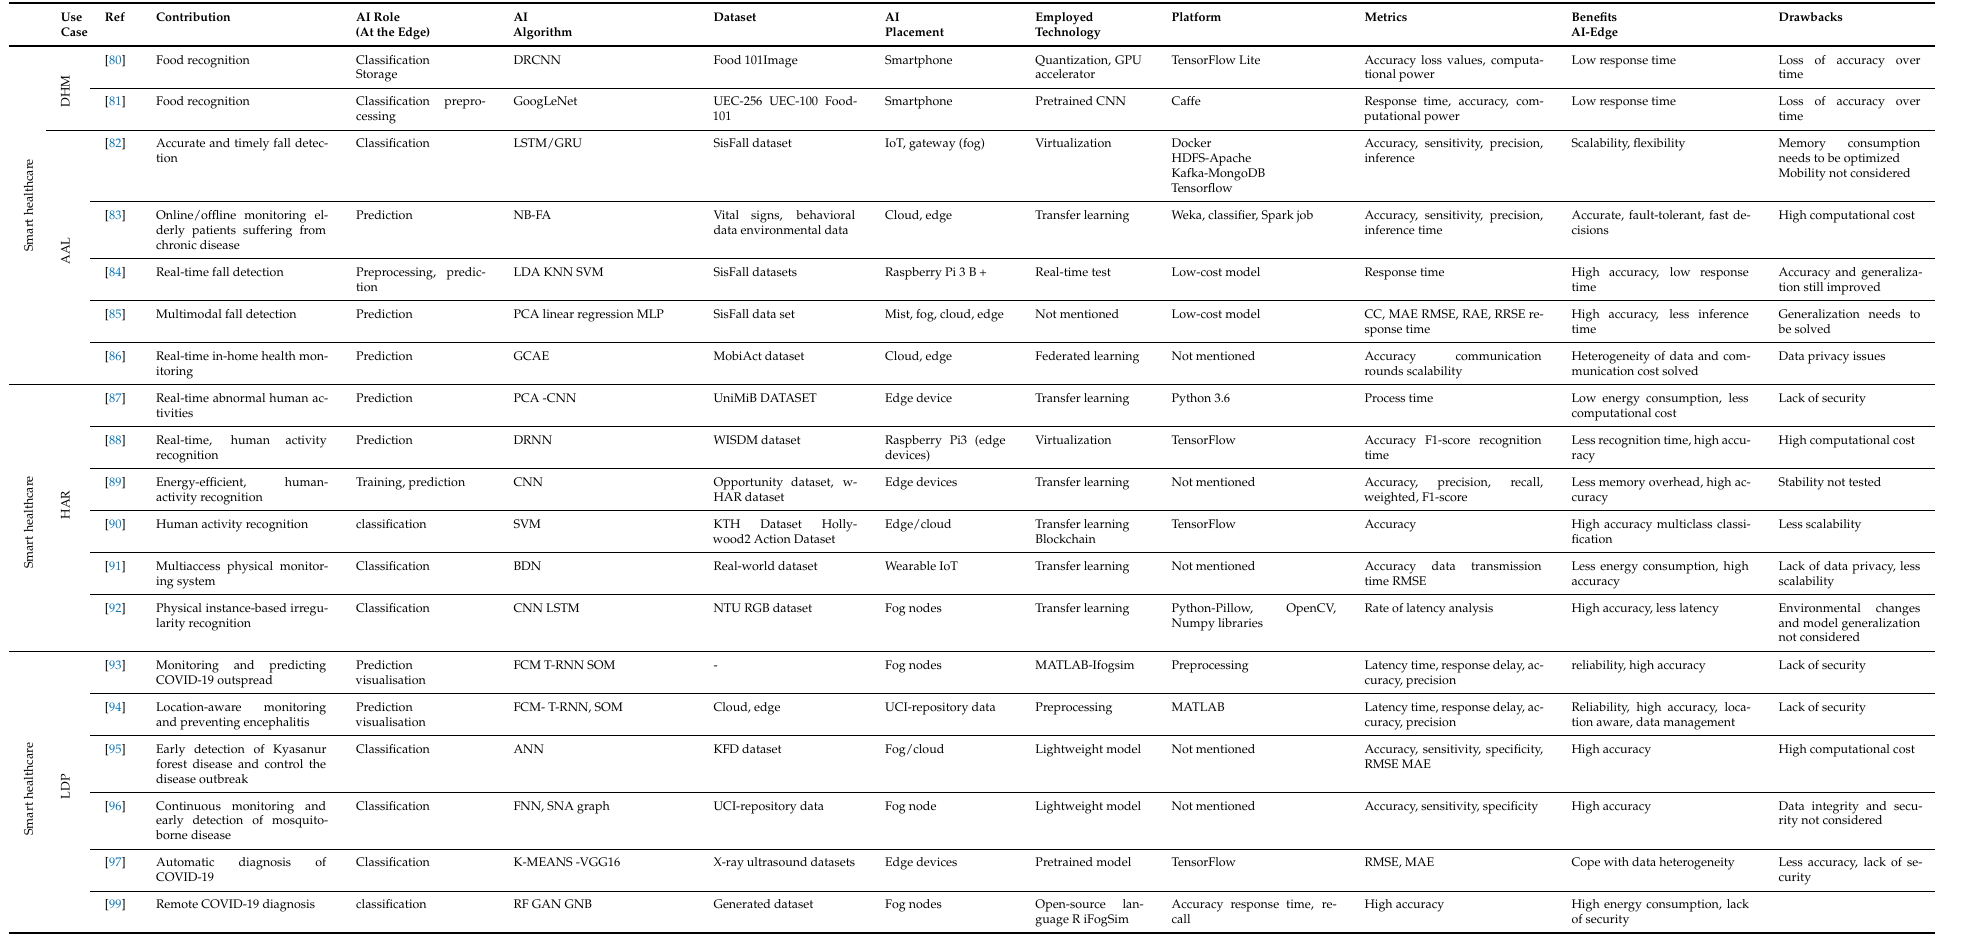
Table 8. Qualitative comparison of smart healthcare-related